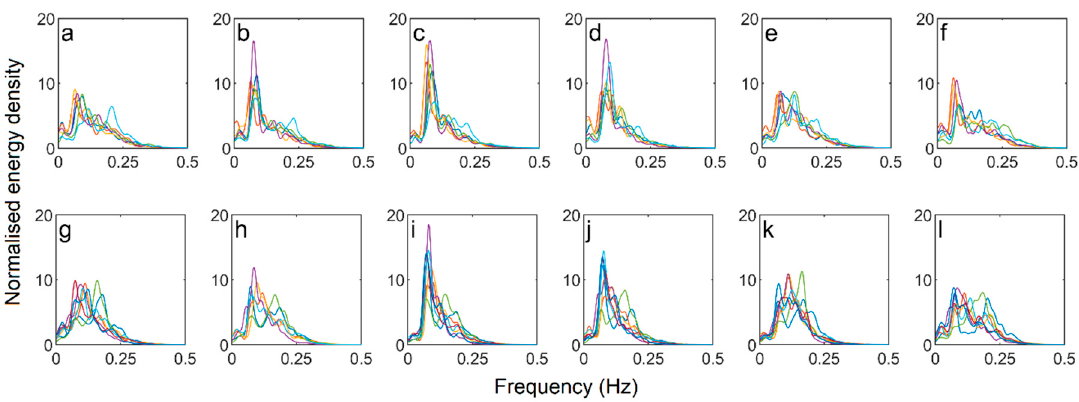
Figure 14. Normalised wave spectra averaged over each high tide at the 6 pressure transducers for deployment one ( a – f ) and deployment 2 ( g – l ). PTs are displayed from west to east; PT1 is the first column ( a , g ) through to PT6 the last column ( f , l ). Different colours indicate different high tides, but it is the envelope of spectral shapes rather than the individual spectra which should be considered. Table 5. Mean and standard deviation of Goda’s peakedness parameter, Q p , for both deployments. Deployment